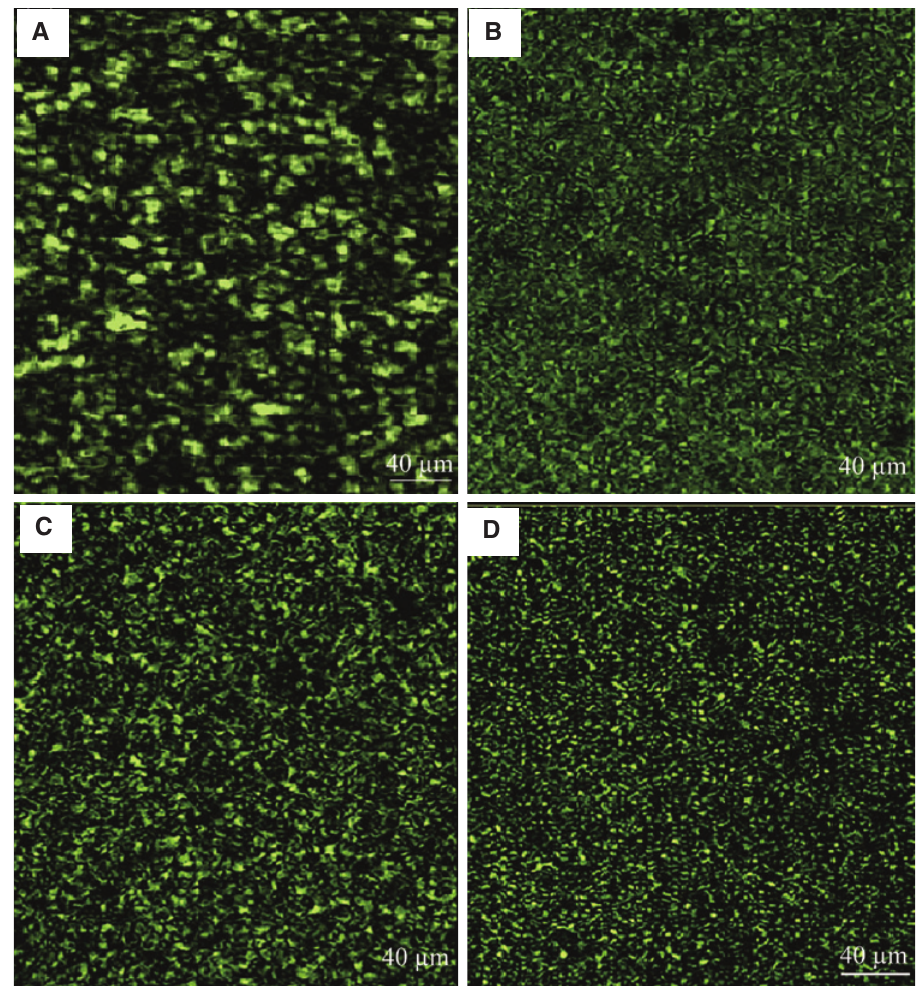
Figure 2: The images of polarized optical micrographs of (A) P1, (B) PN5, (C) PG5, and (D)